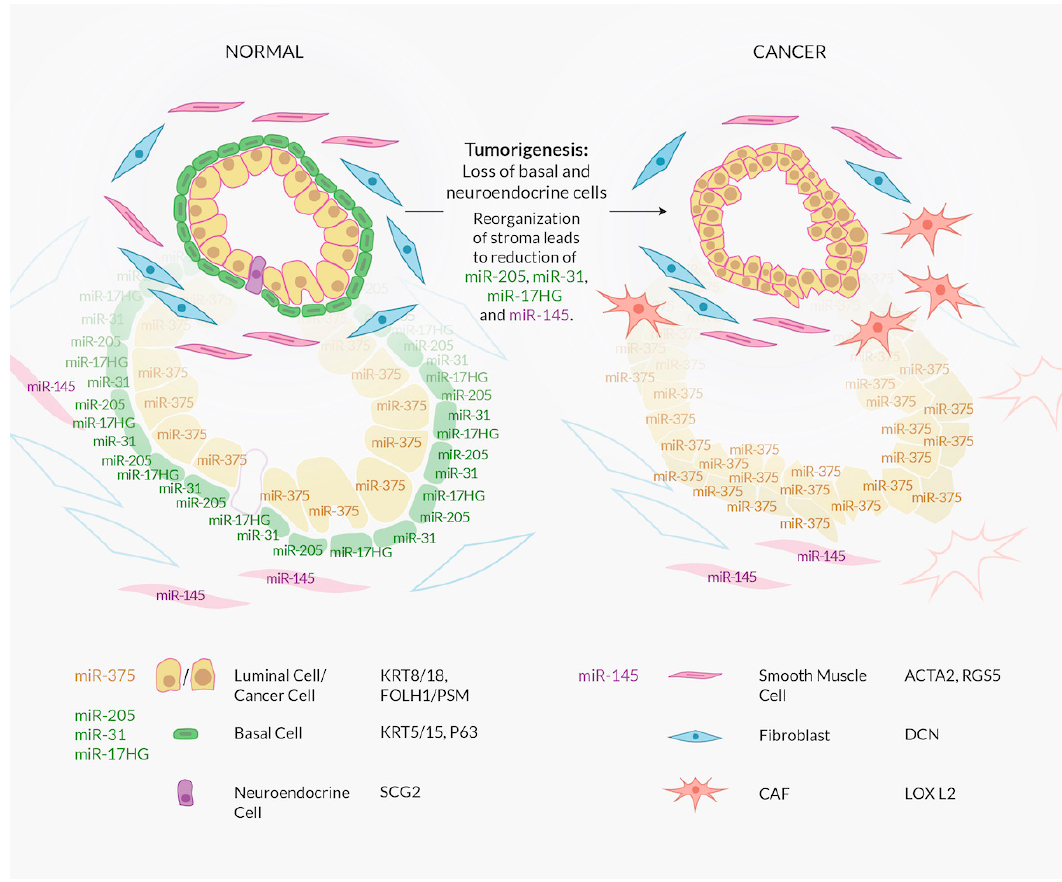
Figure 1. Overview of the changes in tissue organization that underlie some changes in miRNA and protein expression. Reduction in the expression of miR-205, miR-31, miR-145, and the miR-17-92 cluster are frequently observed in prostate cancer studies. These changes can be explained by the loss of basal cells (miR-205, miR-31, and miR-17HG), reorganization of the stroma (reduction in miR-145)